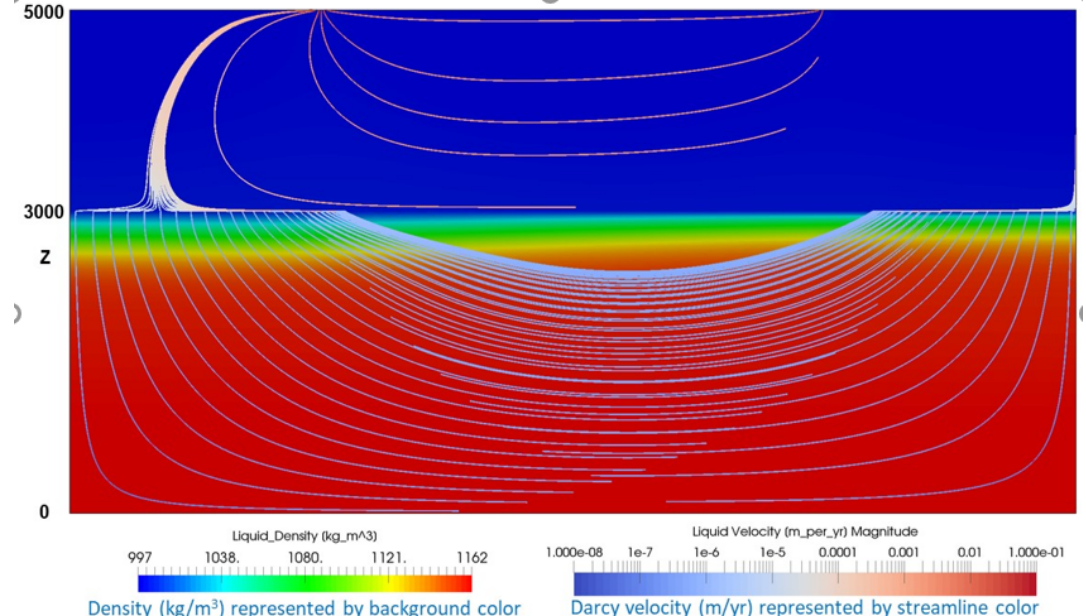
Figure 7. PFLOTRAN DBD-Scale Model Results (Fluid Density and Darcy Flux) .